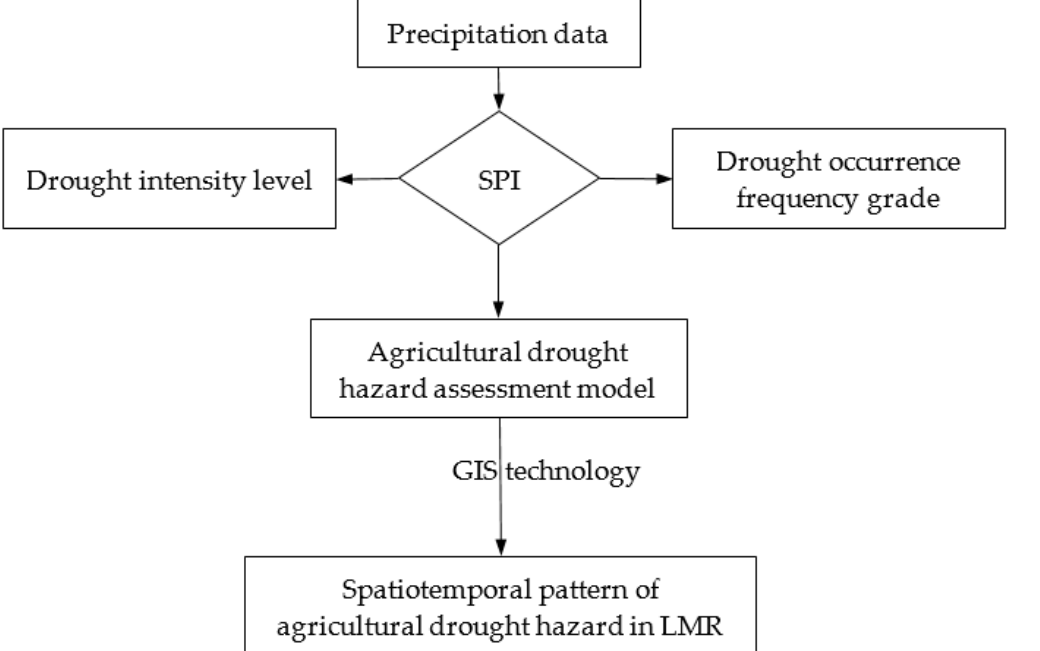
Figure 6. Drought hazard assessment methodology.